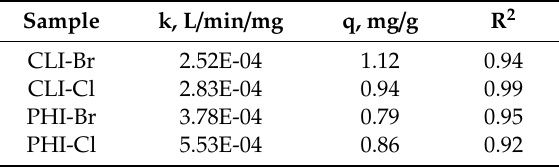
Table 6. Thomas parameters from breakthrough